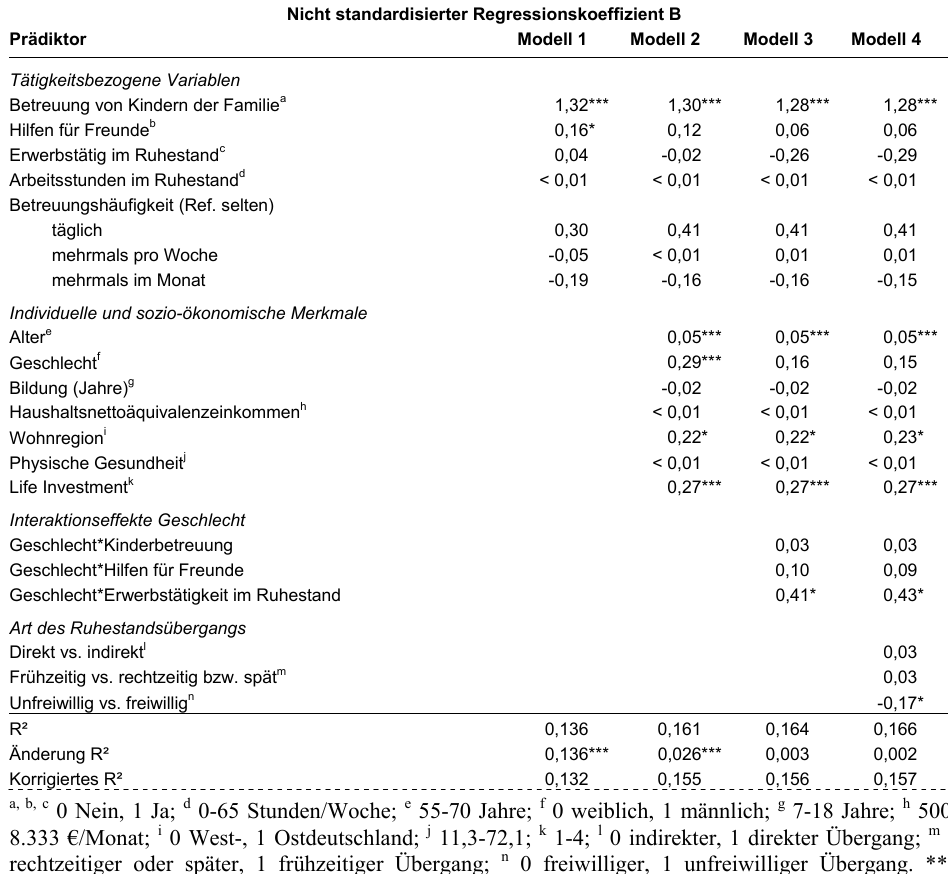
Tabelle 2 : Schrittweises lineares Regressionsmodell zur Prognose der Veränderung von sozialen Beziehungen nach dem Übergang in den Ruhestand ( N =